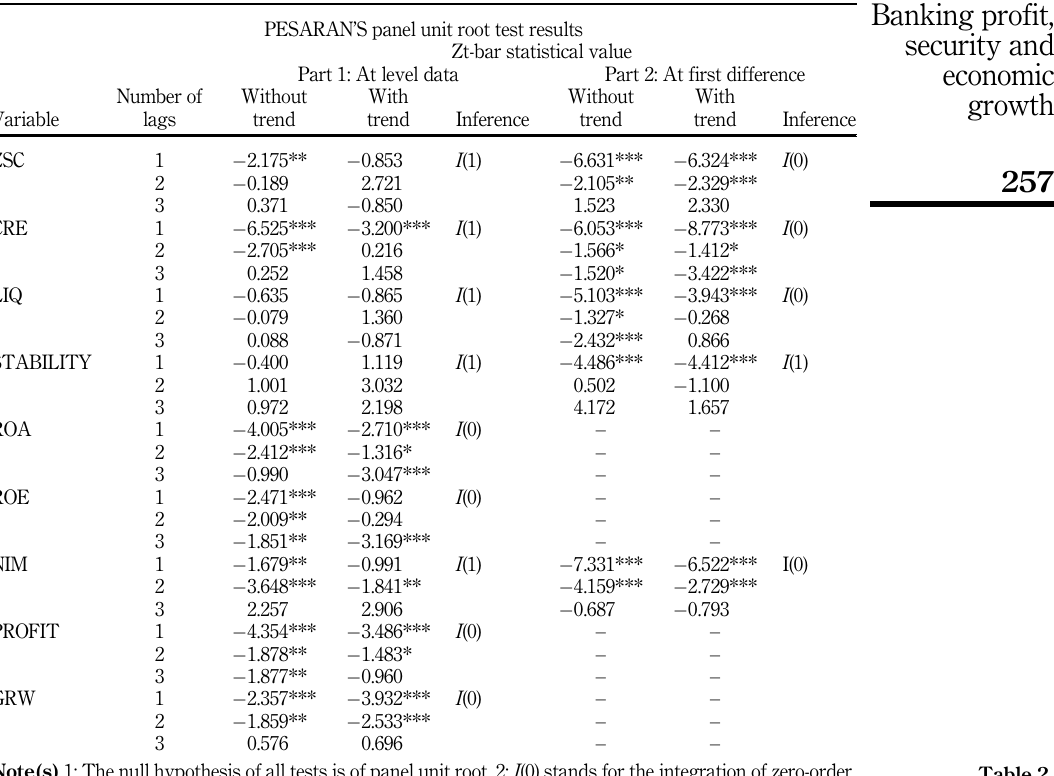
Table 2. Panel unit root test results under the second-generation